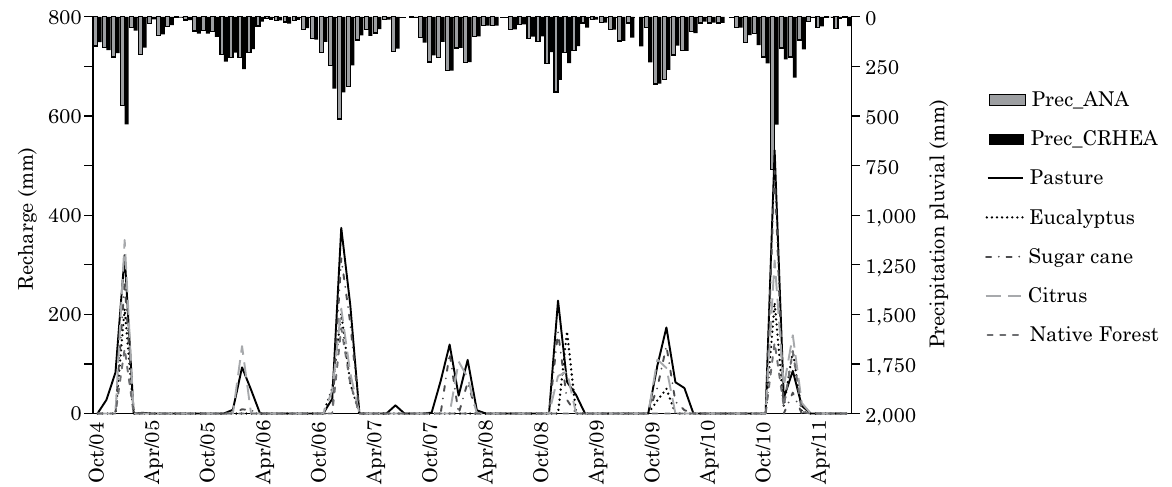
figure 5. monthly recharge rates (colored lines) obtained by the water Balance method using total rainfall from the weather stations ana and crhEa (vertical